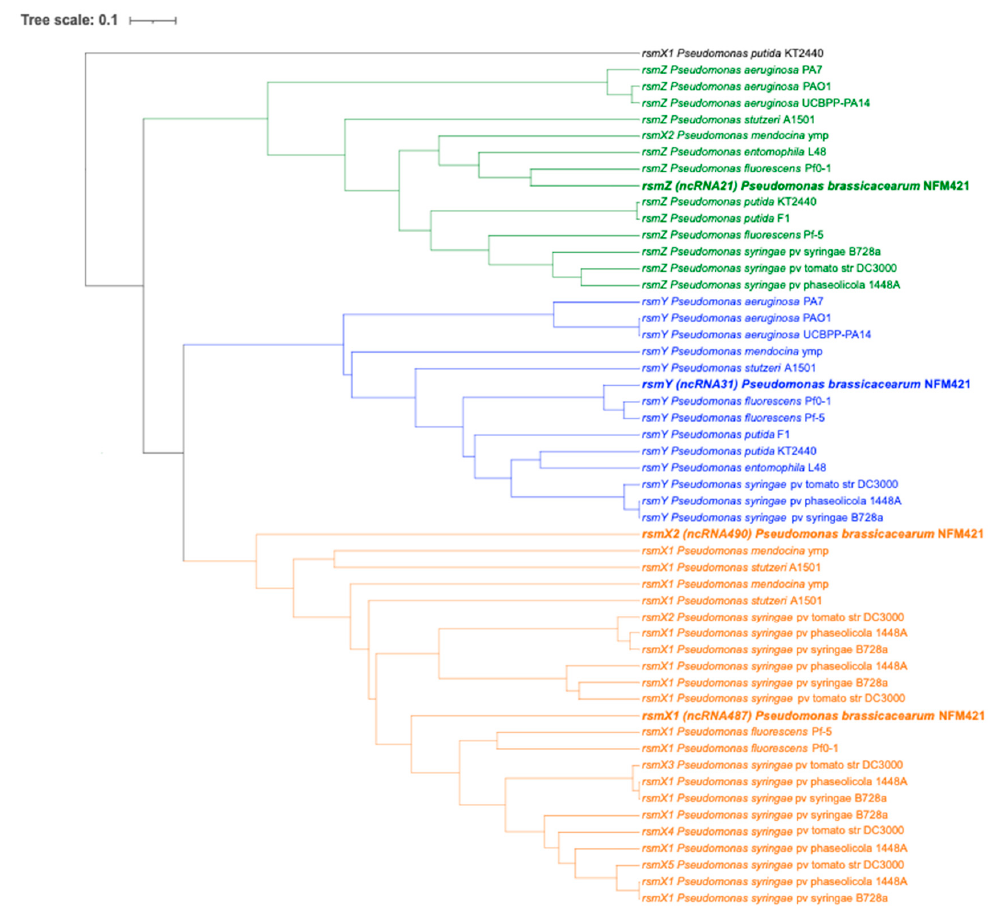
Figure 2. Phylogenetic analysis of rsm RNA sequences. rsm genes from P. brassicacearum NFM 421 are shown in bold.